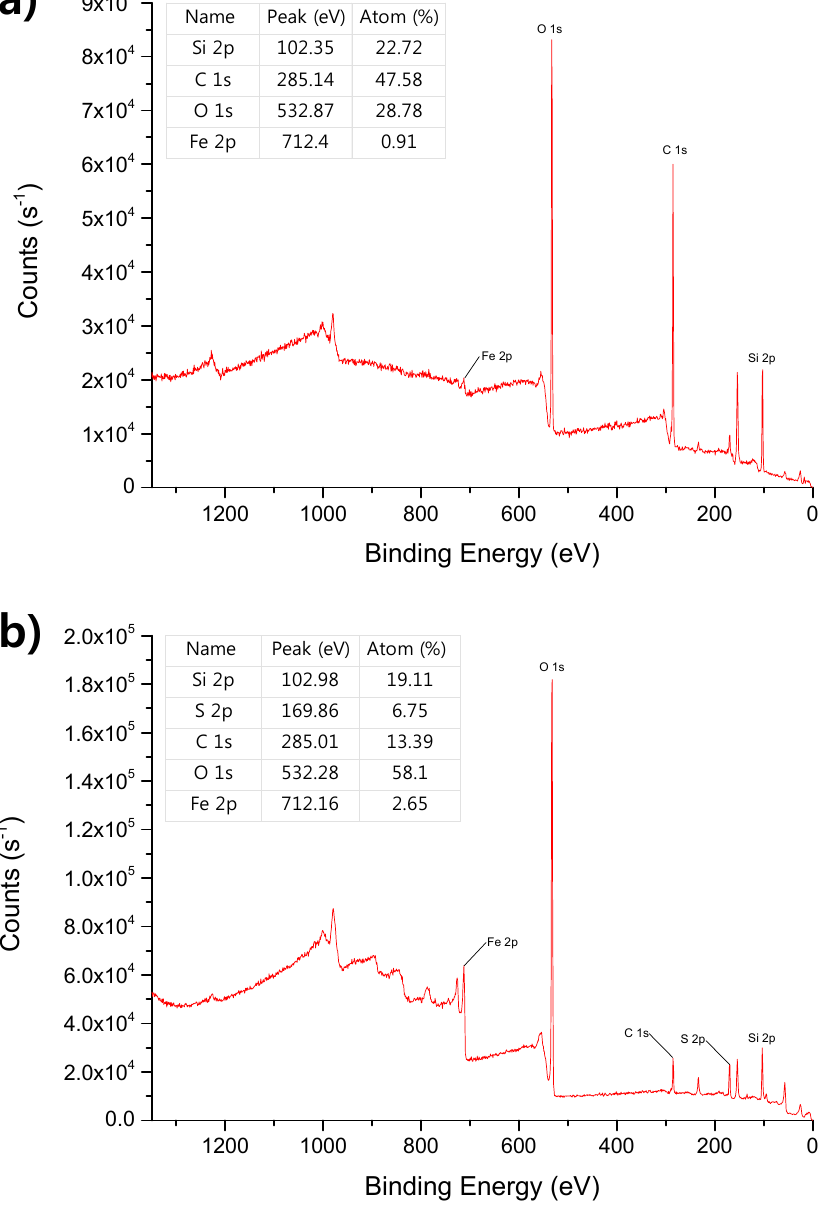
Figure 4. X-ray photoelectron spectroscopy (XPS) analysis for the cathode layer of the FeS 2 /PIS: ( a ) after the formation of the cathode composites at 250 °C; ( b ) after a 1 h treatment at 450 °C.